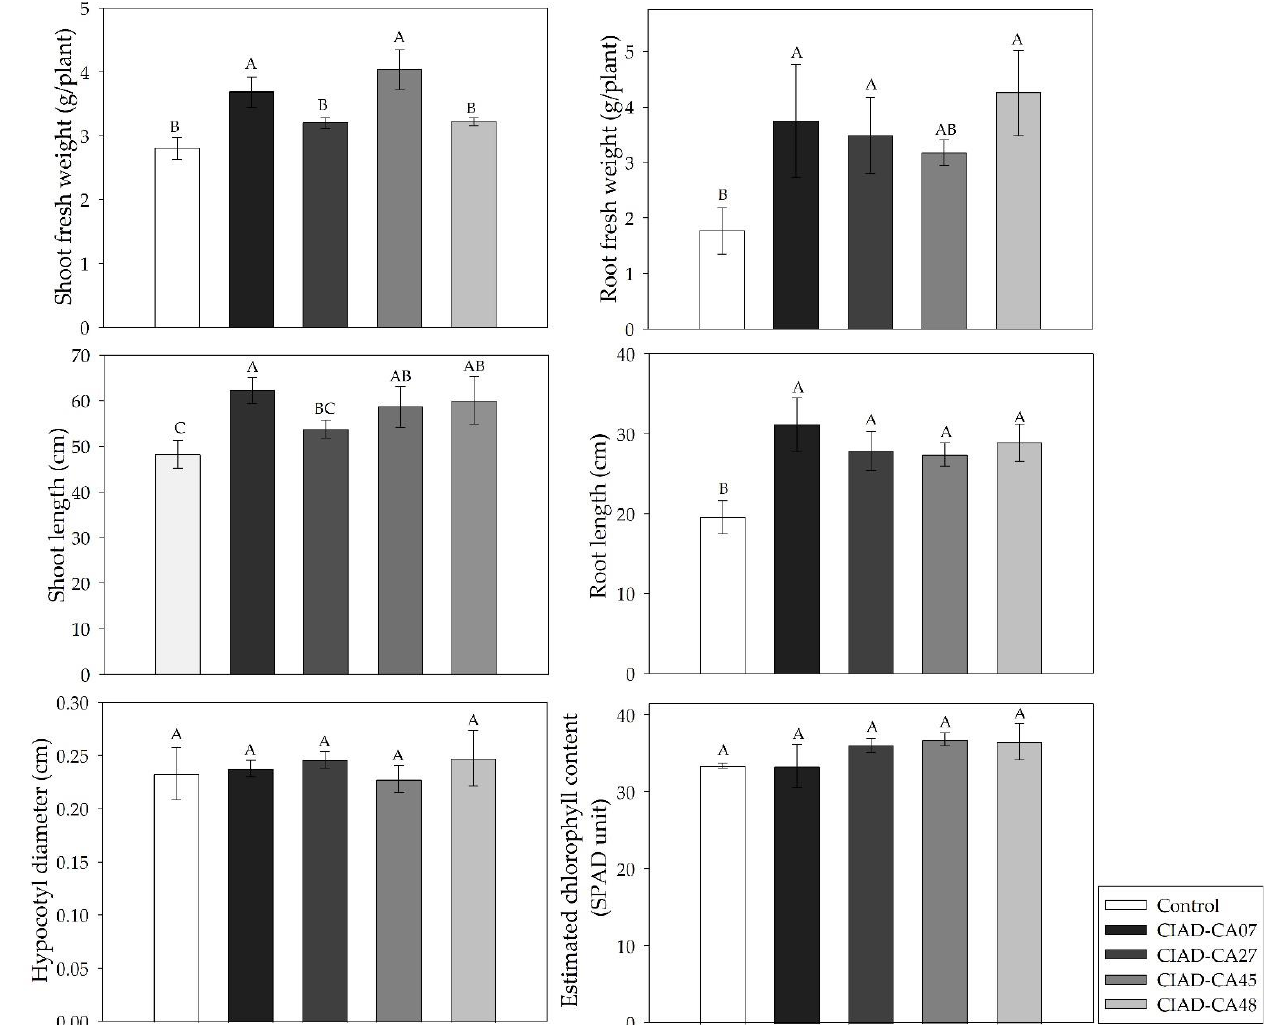
Figure 5. Effects of the inoculation of P . vulgaris seedlings with Streptomyces strains on biomass production. Mean values with the same letters are statistically similar. Thin upper bars indicate the standard deviations of the means.